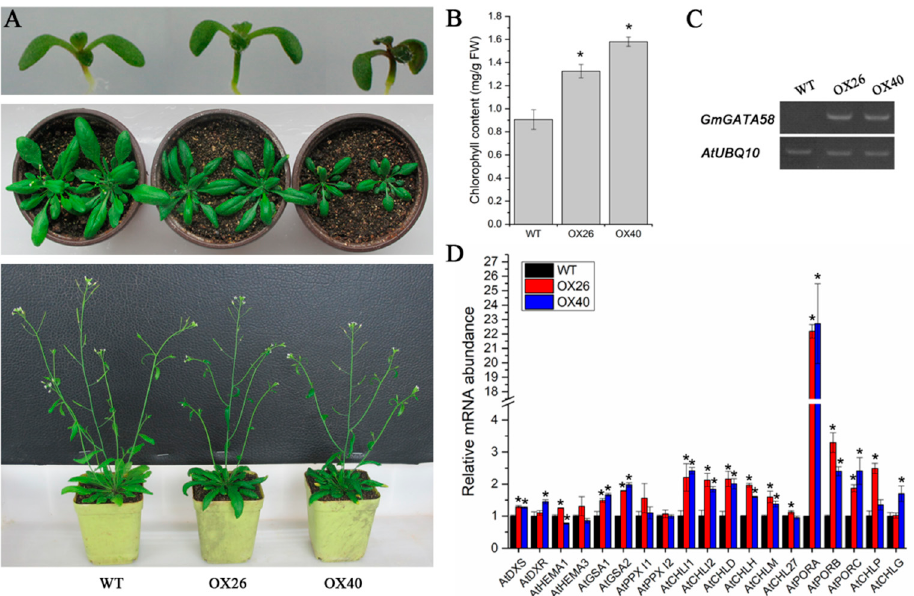
Figure 5. Overexpression analysis of GmGATA58 gene in Arabidopsis thaliana ecotype Columbia. ( A ) Phenotypic observation of the wild-type (WT) and two independent T 3 overexpression lines (OX26 and OX40) at one week (upper panel), four weeks (middle panel) and five weeks (bottom panel) of post-germination. ( B ) The chlorophyll content measurement in three-week-old rosette leaves of WT, the OX26 and OX40 transgenic plants. Data are presented as mean ± SD error bar ( n = 10) from three independent measurements. Asterisks (*) indicate significant differences against the wild-type plant at p < 0.05. ( C ) Semi-quantitative assay of GmGATA58 gene in rosette leaves of WT, the OX26 and OX40 transgenic plants. AtUBQ10 gene was used as the internal reference gene. ( D ) qPCR assay of chlorophyll biosynthetic pathway genes in the leaves of WT and two overexpression lines (OX26 and OX40). Data are normalized using AtGAPDH as the reference gene and shown as a percentage of the expression in the wild-type plant. Asterisks (*) indicate significant differences against the wild-type plant at p < 0.05.